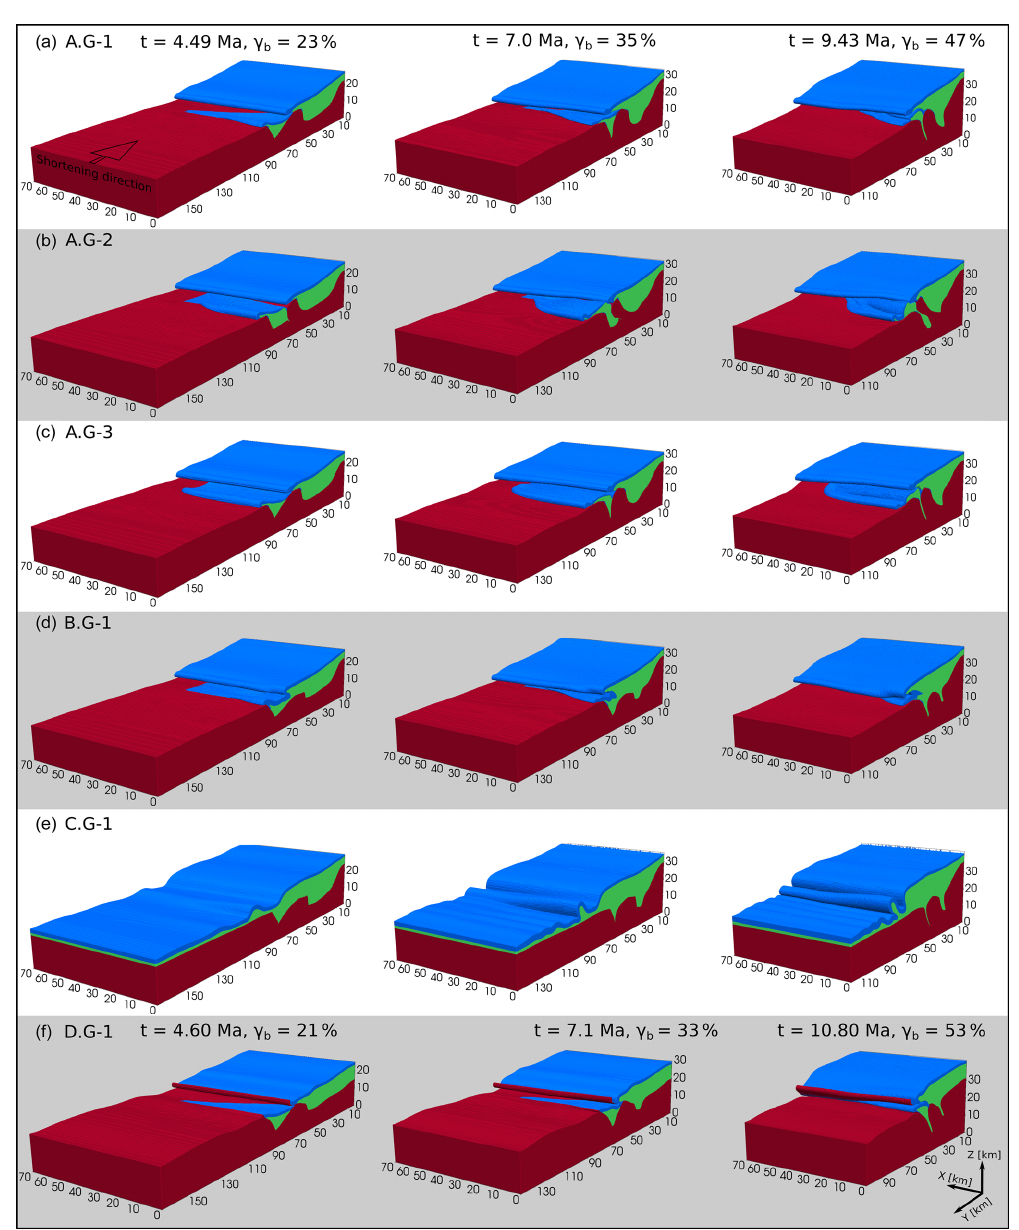
Figure 4. 3-D model evolution for our six simulations, using a graphical threshold to highlight the deformation of the strong layer, weak units and the basement. Rows correspond to the configuration and columns to the total bulk shortening γ b